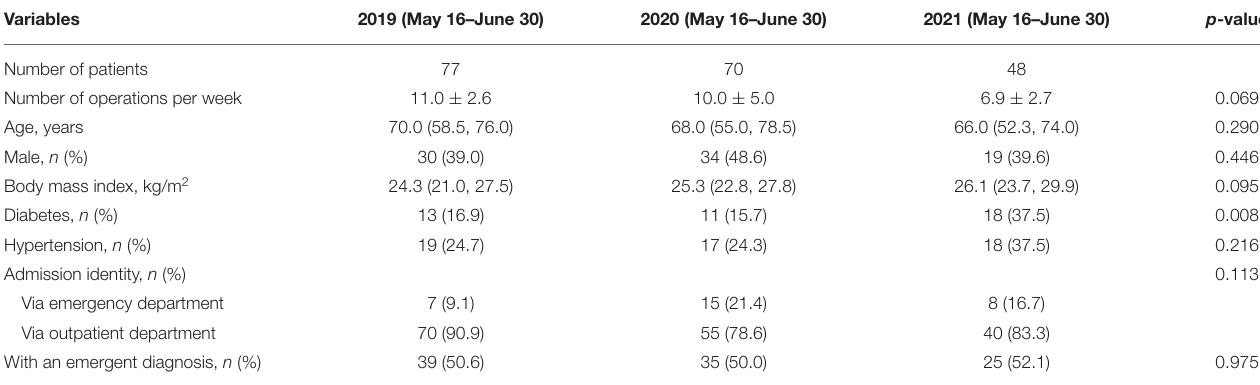
TABLE 1 | Characteristics of the study population according to the year of surgery.